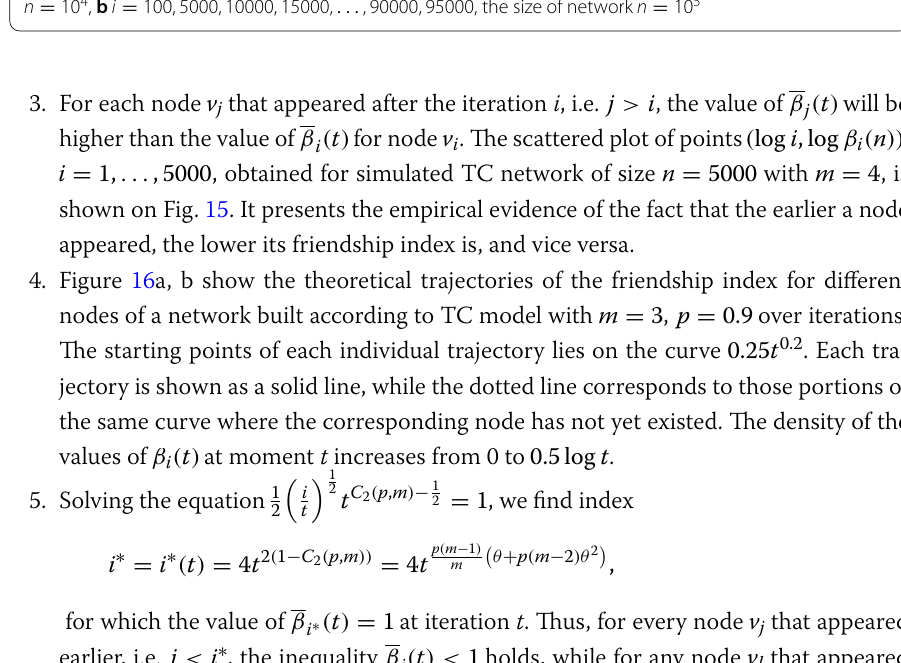
higher than the value of β i ( t ) for node v i . The scattered plot of points ( log i , log β i ( n )) ,